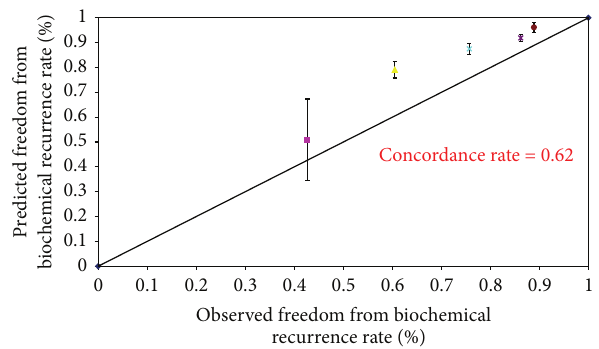
Figure4:Observedversuspredicted5-yearfreedomfrombiochem- ical recurrence rates according to the 2006 Stephenson nomogram.